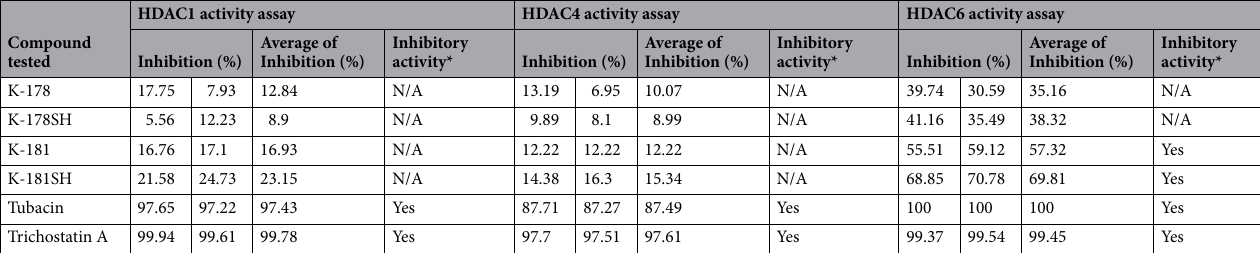
Table 1. HDAC1, HDAC4 and HDAC6 inhibition assay of K-178, K-178SH, K-181, K-181SH, Tubacin and Trichostatin A. *HDAC inhibitory effect is defined as “Average of Inhibition (%)” >